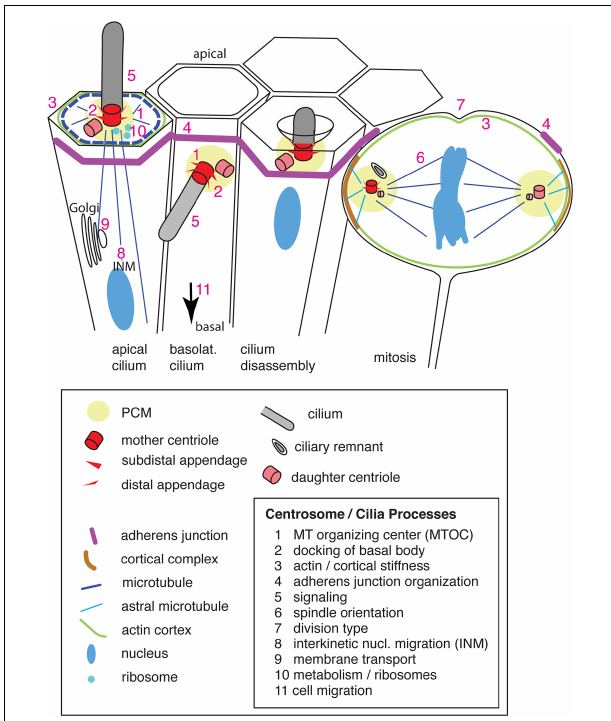
FIGURE 1 | Primary cilia and centrosomes in the ventricular zone of the developing neocortex, their structure and components. Apical progenitors exhibit an apical primary cilium, which is connected by microtubules that originate from the basal body [microtubule organizing center (MTOC)], to the cortical actin and microtubule network and the adherens junction belt. The nucleus, connected by microtubules to the centrosome, undergoes interkinetic nuclear migration (INM). Vesicles are transported along microtubules from the Golgi complex toward the apical plasma membrane and primary cilium. Newborn basal progenitors exhibit a primary cilium on the basolateral plasma membrane, which initially is still integrated in the adherens junction belt prior to delamination (arrow). Primary cilia are disassembled prior to mitosis by resorption in a ciliary pocket. During mitosis the centrosomes act as spindle poles which are anchored via astral microtubules to the cell cortex (enriched for the NuMA/LGN/G α i complex). A ciliary remnant is localized in the vicinity of the older mother centriole. Numbers indicate the sites of the corresponding processes. Only the apical domain of the cells is